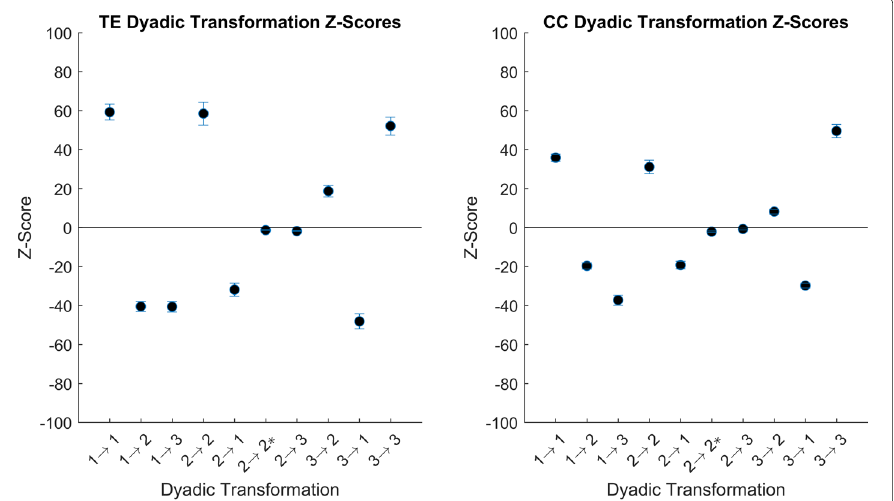
Fig. 6 Dyadic Z -scores for κ = 0.2. Average and standard deviations of Z -scores for both TE and CC methods with κ = 0.2. We note that transformations 2 → 2 ∗ and 2 → 3 are close to zero while all other transformations are far from zero. All preservation transformations, 1 → 1, 2 → 2 and 3 → 3 are overrepresented while conversion transformations, aside from the two previously mentioned, are underrepresented. All transformations exhibit low standard